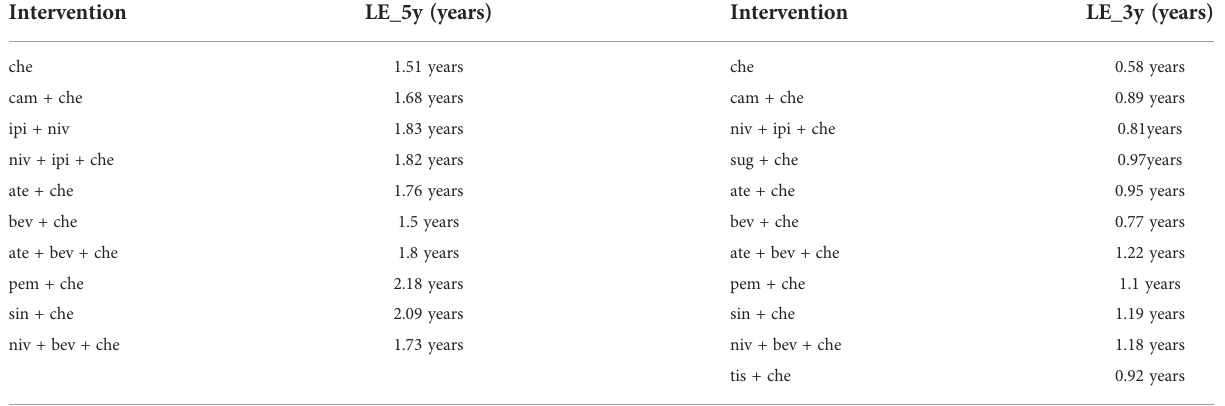
TABLE 2 Life-years gained of OS and